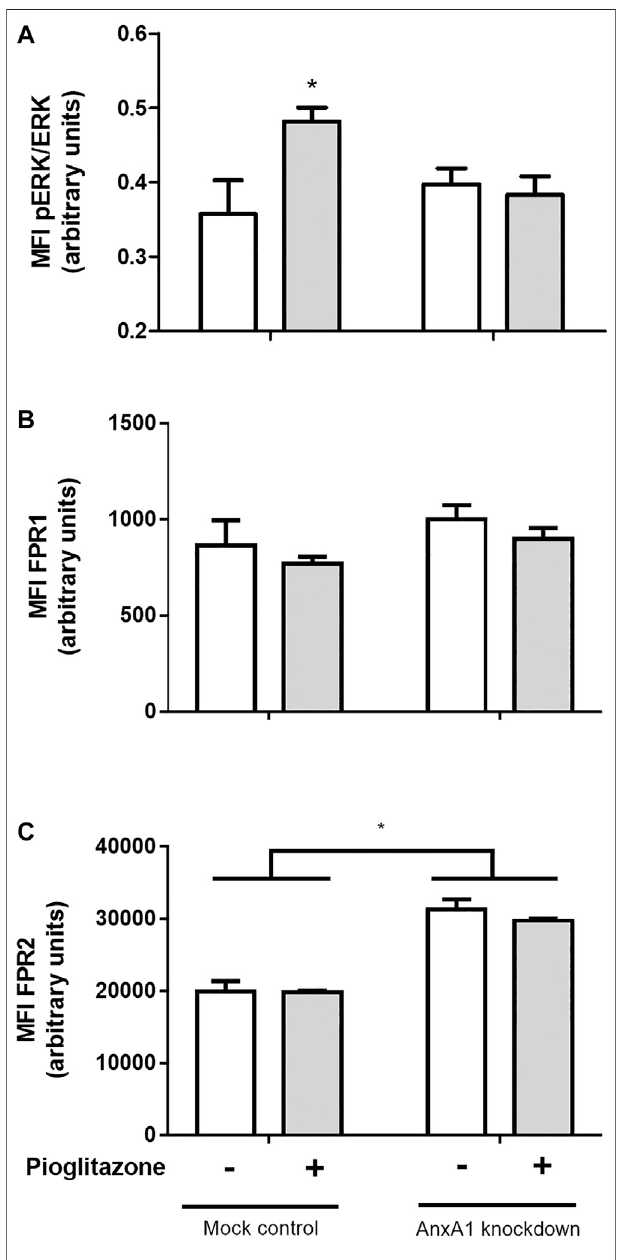
FIGURE 8 | Phosphorylation of ERK and expression of FPR1 and FPR2 in transfected RAW 264.7 macrophages. Mock-transfected and AnxA1- knockdownRAW264.7cellswereplatedandtreatedwith10 µMpioglitazone for 1 h. Cells were harvested and both ERK phosphorylation (A) and expression of FPR1 (B) and FPR2 (C) were assessed via fl ow cytometry. * p < 0.05incomparisontothecontrolgroup.Datawerestatisticallyanalyzedusing One-WayANOVAfollowedbyTukey ’ spost-test( n (cid:2) 4).Resultsareexpressed as mean ± SE.